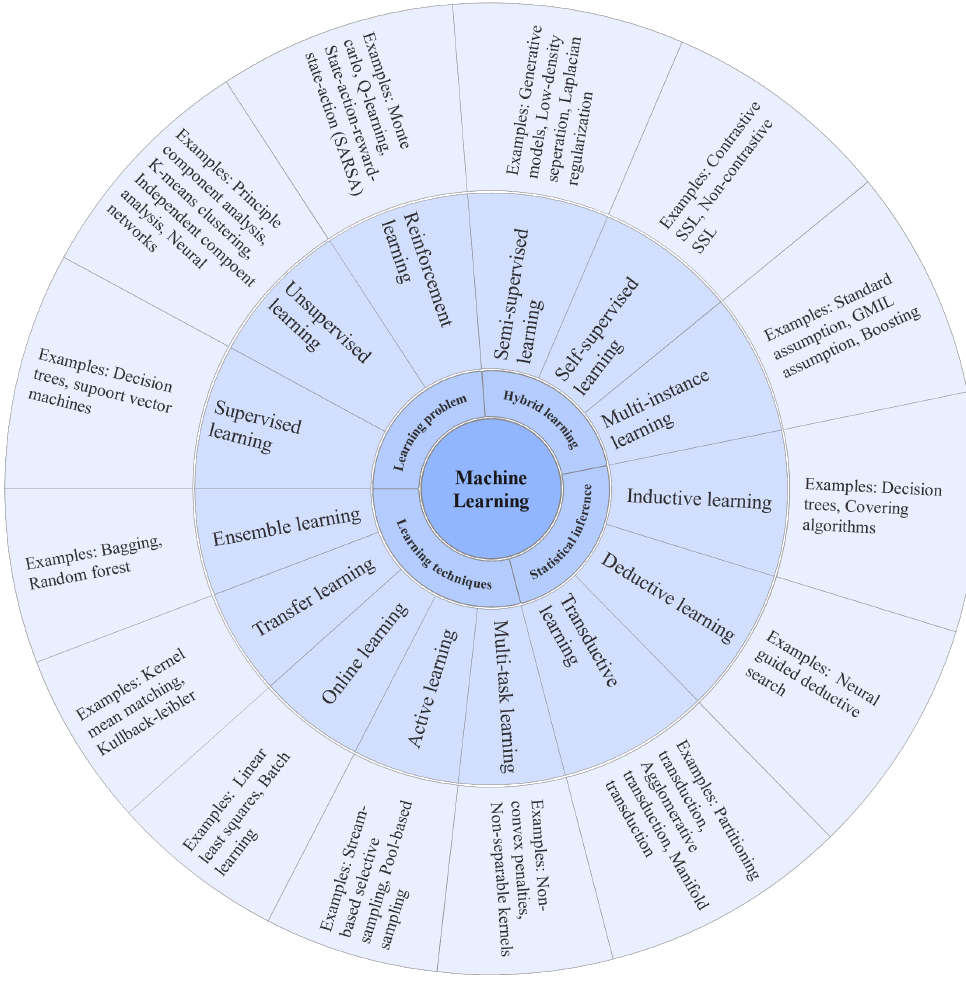
Figure 1. Different types of machine learning